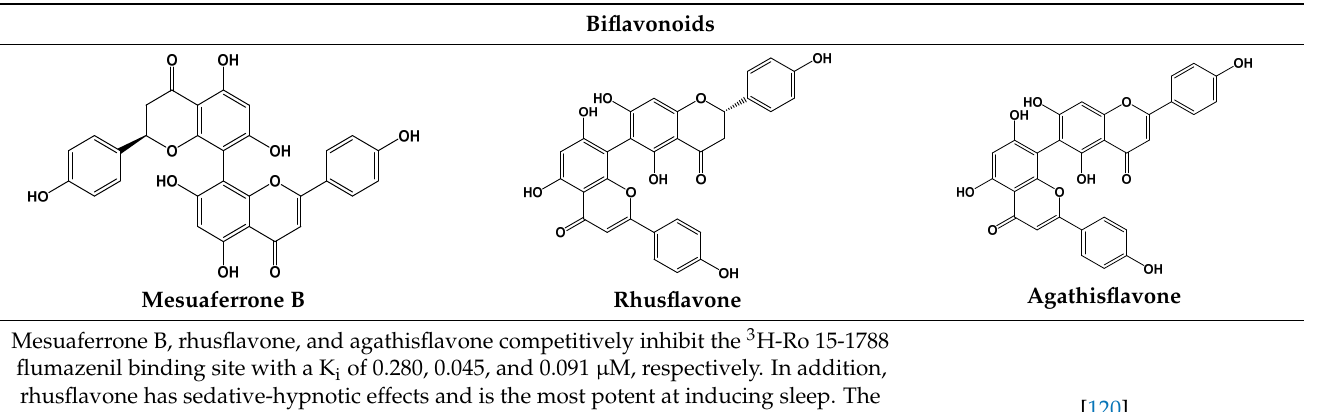
Table 5. Biflavonoids with relevant GABAergic effects.